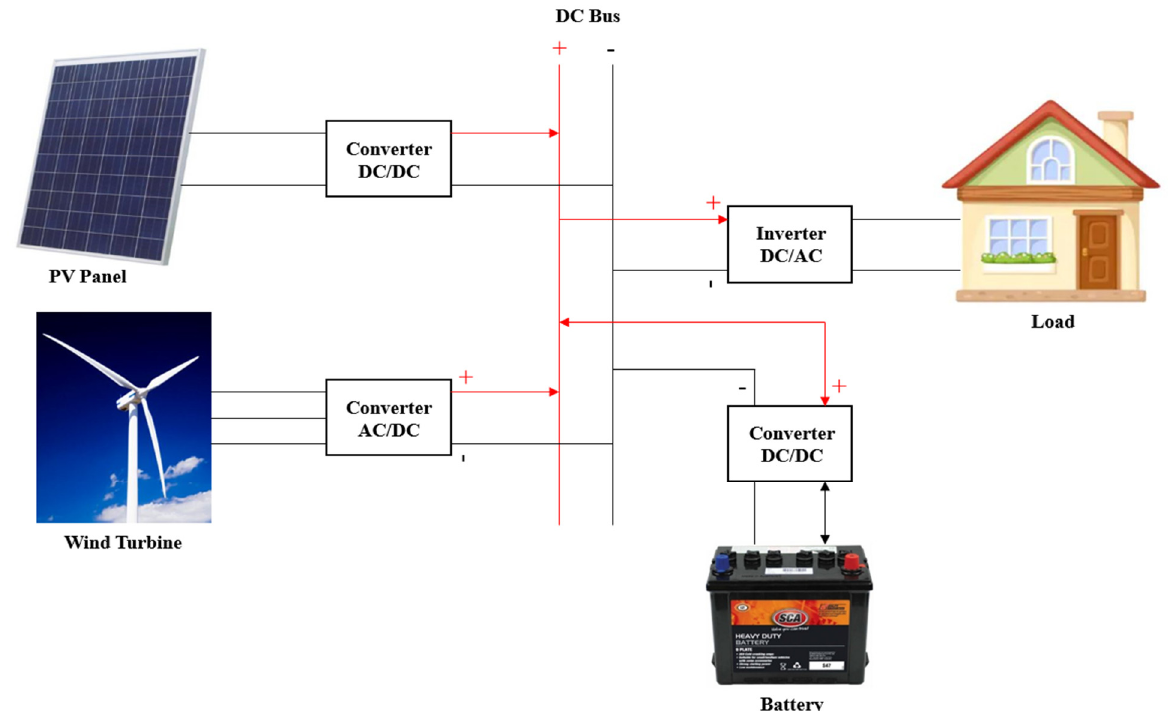
Figure 4. Schematic description of the PV/wind/battery-based hybrid system.